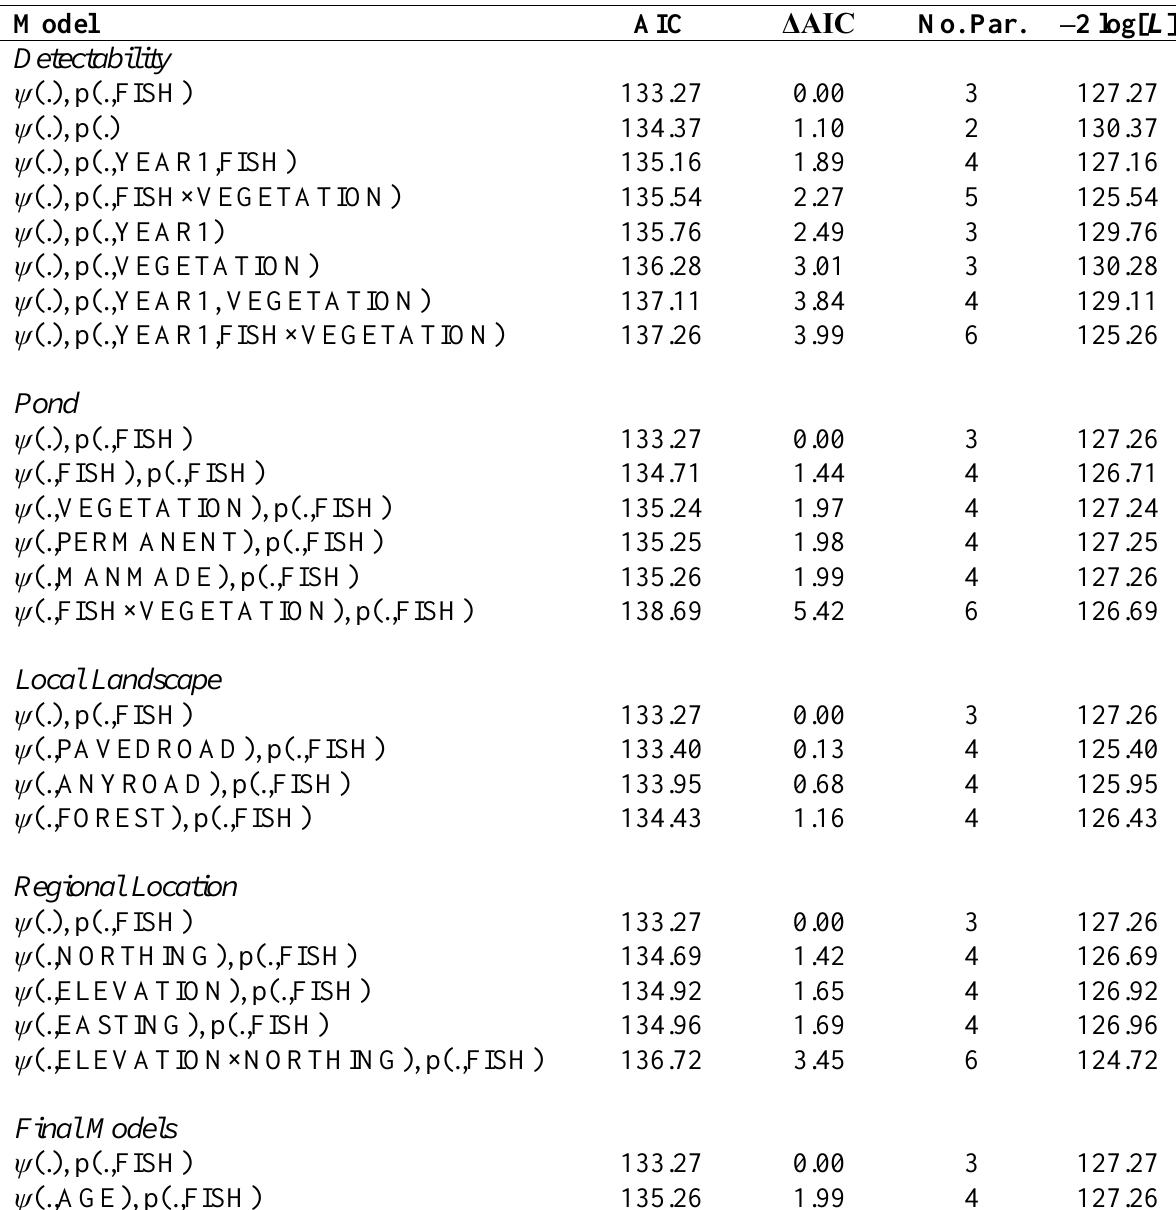
Table 3. Ranking for models of detectability (p) and occupancy (ψ) for historical R. cascadae breeding sites (N = 66) in Cascade Range, Oregon, USA. First models are detectability alone; subsequent groups are models of occupancy that incorporate top-ranked detectability covariate (see